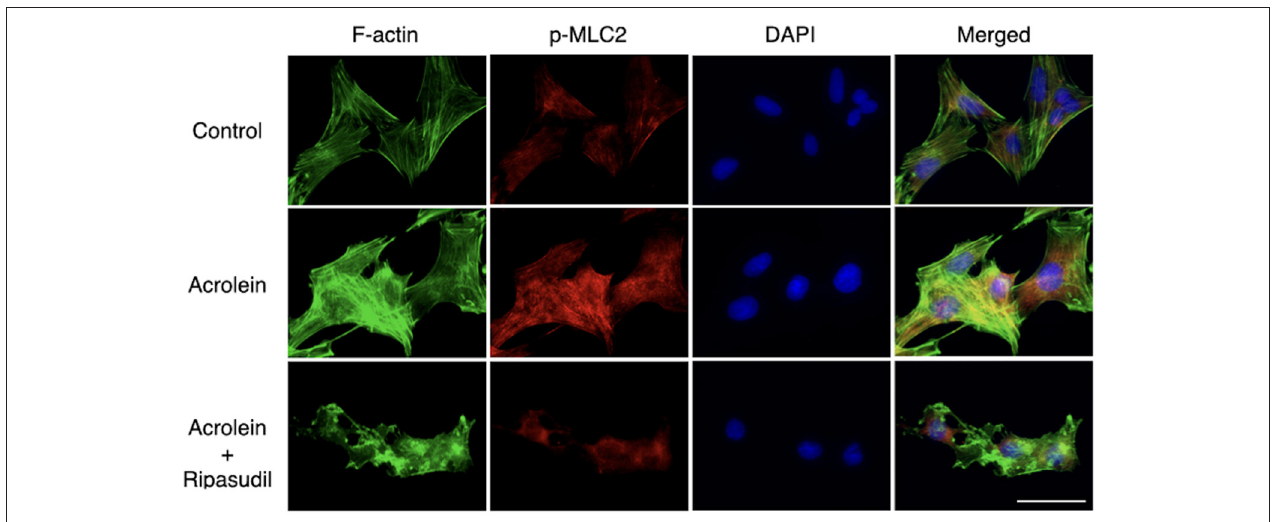
FIGURE 6 | Changes in cellular morphology and stress fiber formation in TR-MUL5 cells treated with acrolein and ripasudil. Representative fluorescent staining patterns of F-actin (green, Acti-stain TM 488) and p-MLC2 (red, Alexa Fluor ® 546) in TR-MUL5 cells treated with acrolein (25 µ M) and/or ripasudil (2 µ M). Blue, nuclei counterstained with DAPI. Scale bar, 50 µ